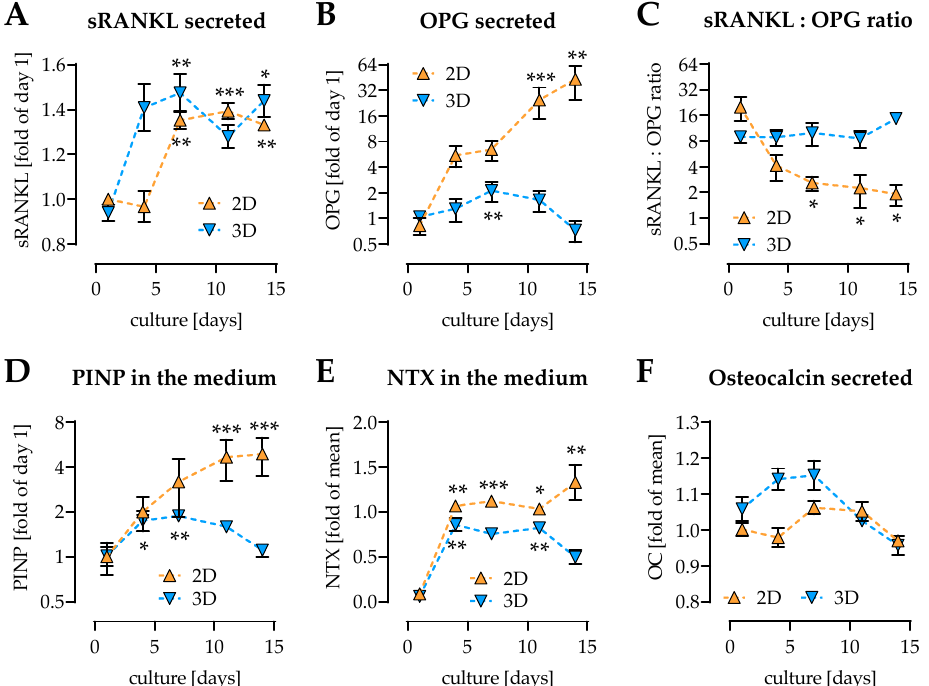
Figure 3. Secreted markers for osteoblast and osteoclast function in 2D and 3D cocultures of THP-1 cells and SaOS-2 cells. THP-1 cells and SaOS-2 cells (2:1 ratio) were cocultured over 14 days in both 2D and 3D on pHEMA-based cryogel scaffolds. On days 1, 4, 7, 10, and 14 of culture, ( A ) soluble receptor activator of nuclear factor kappa-B ligand (sRANKL), ( B ) osteoprotegerin (OPG), and ( C ) the sRANKL:OPG ratio, ( D ) procollagen type I N-terminal propeptide (PINP), ( E ) collagen-type I N-telopeptide (NTX), and ( F ) osteocalcin levels were detected in the culture supernatant. Data are presented as curves (mean ± SEM). Changes over time were compared by nonparametric Friedmann test, followed by Dunn’s multiple comparison test. * p < 0.05, ** p < 0.01, and *** p < 0.0001 as compared to day 1. N = 3, n = 2.